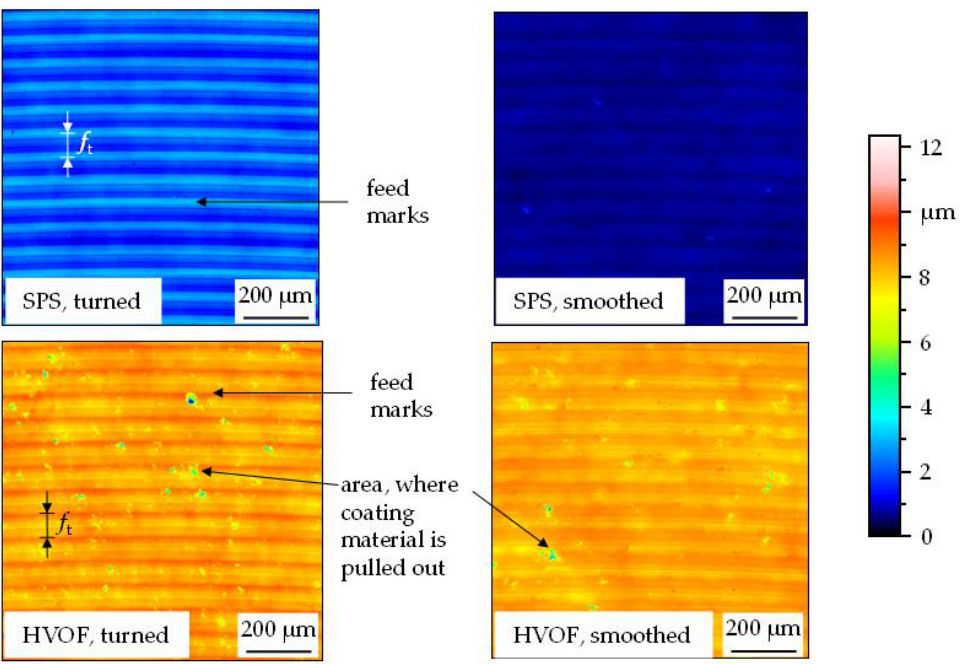
Figure 1. Surfaces after machining detected by 3D laser scanning